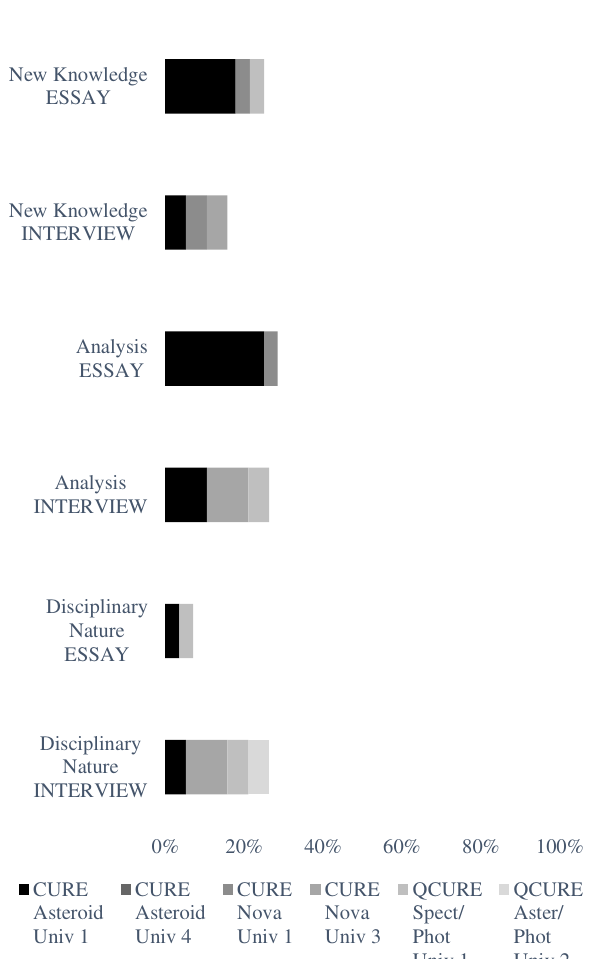
FIG. 6. Percentage of responses represented within each theme regarding the category of process of science, shaded by course type, project, and institution. Themes were generated from qualitative analyses of students ’ postinstruction essay ( n ¼ 28 ) and interview responses ( n ¼ 19 ) characterizing RBSEU instruc- tion compared to previous